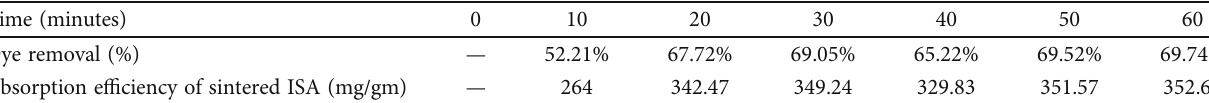
Table 4: Dye removal percentage and adsorbent ’ s capacity.